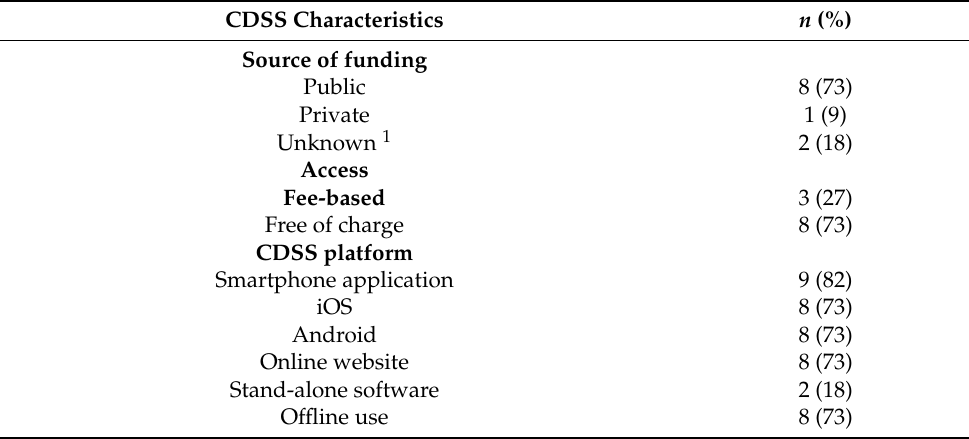
Table 1. Main characteristics of the CDSSs . CDSS Characteristics